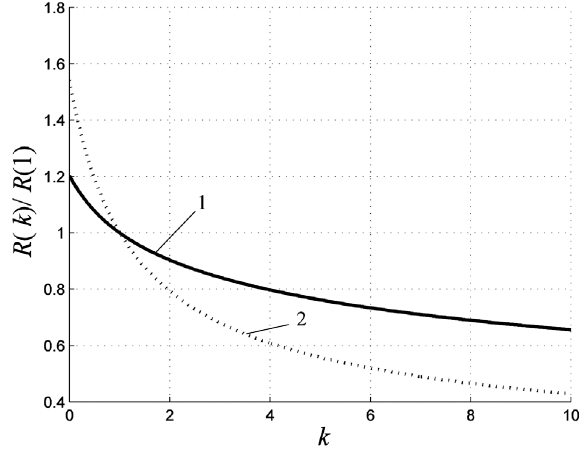
Figure 2. Total columnar resistance R of the atmospheric surface layer versus parameter k = c / c . The lines 1 and 2 correspond to r 0 c 0 aerosol number densities of 2×10 2 cm -3 and 1.5×10 3 cm -3 , respec- tively. The plots are normalized to the value of R taken at k =1.